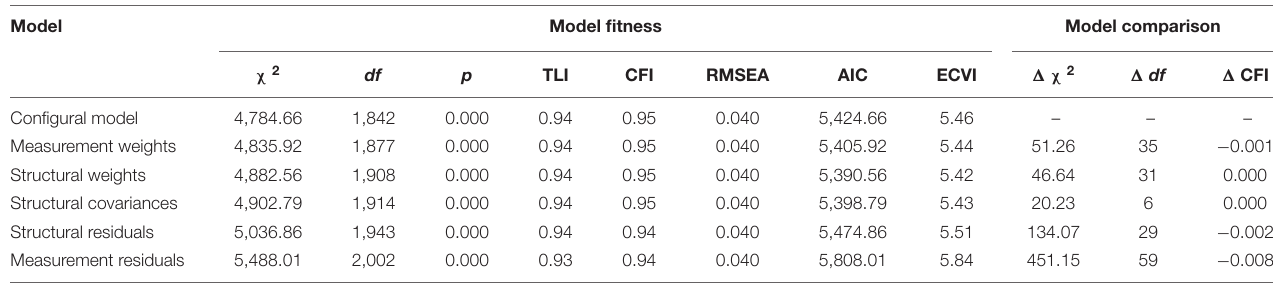
TABLE 3 | Results of multi-group analysis across Master’s and Doctoral